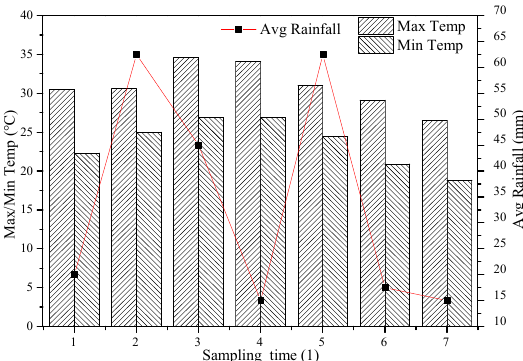
Figure 2. Distribution of the mean monthly temperature and rainfall during the experiment.